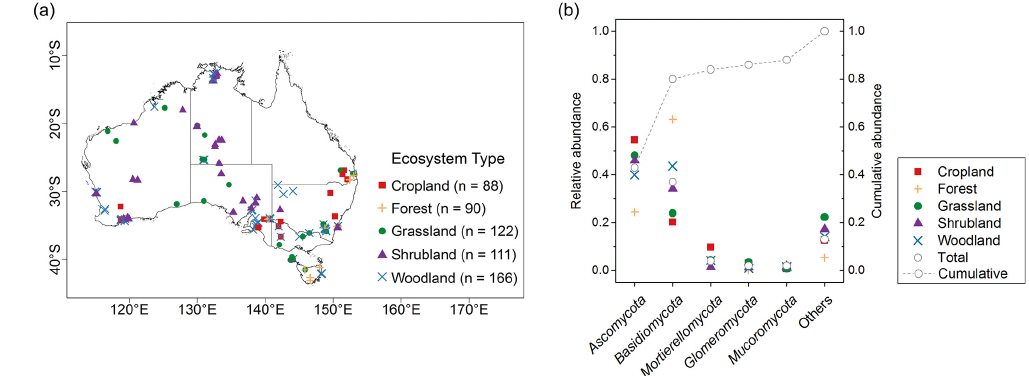
Figure 1. (a) Sampling sites and the range of ecosystem types across Australia. (b) The mean relative abundances of dominant fungal phyla and unclassified “Others” taxa in five ecosystem types. Individual abundance of each phylum and their cumulative abundance were shown in the